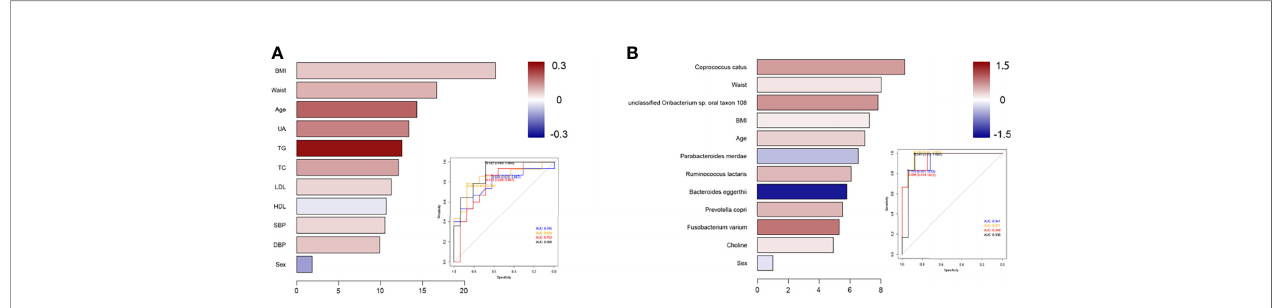
FIGURE 3 | Classi fi cation models using selected indicators to identify prediabetes or diabetes patients from controls. (A) The selected traditional risk indicators distinguished prediabetes from control based on the Random Forest model. The lengths of bar in the histogram represent Gini coef fi cient, which indicates the importance of the indicators for classi fi cation. The color denotes the enrichment of indicators in control (blue) and in prediabetes or diabetes (red). ROC of classi fi er models using four groups of biomarkers for prediabetes versus control. AUC = 0.785 for biomarkers 1 (blue curve), AUC = 0.839 for biomarkers 2 (yellow curve), AUC = 0.792 for biomarkers 3 (red curve), and AUC = 0.888 for biomarkers 4 (black curve). (B) The ANOVA-selected indicators distinguish diabetes from control based on the Random Forest model. ROC of classi fi er models using four groups of biomarkers for diabetes versus control. AUC = 0.941 for biomarkers 1 (blue curve), AUC = 0.971 for biomarkers 2 (yellow curve), AUC = 0.948 for biomarkers 3 (red curve), and AUC = 0.938 for biomarkers 4 (black